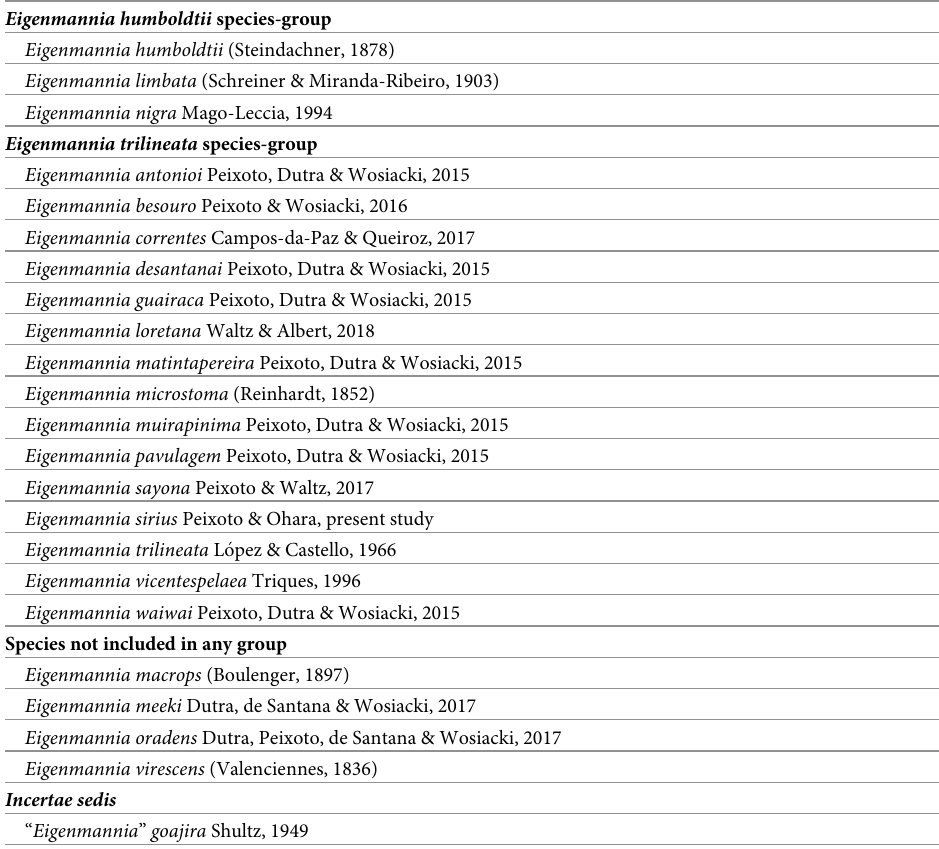
Table 2. Taxonomic arrangement of species group in Eigenmannia